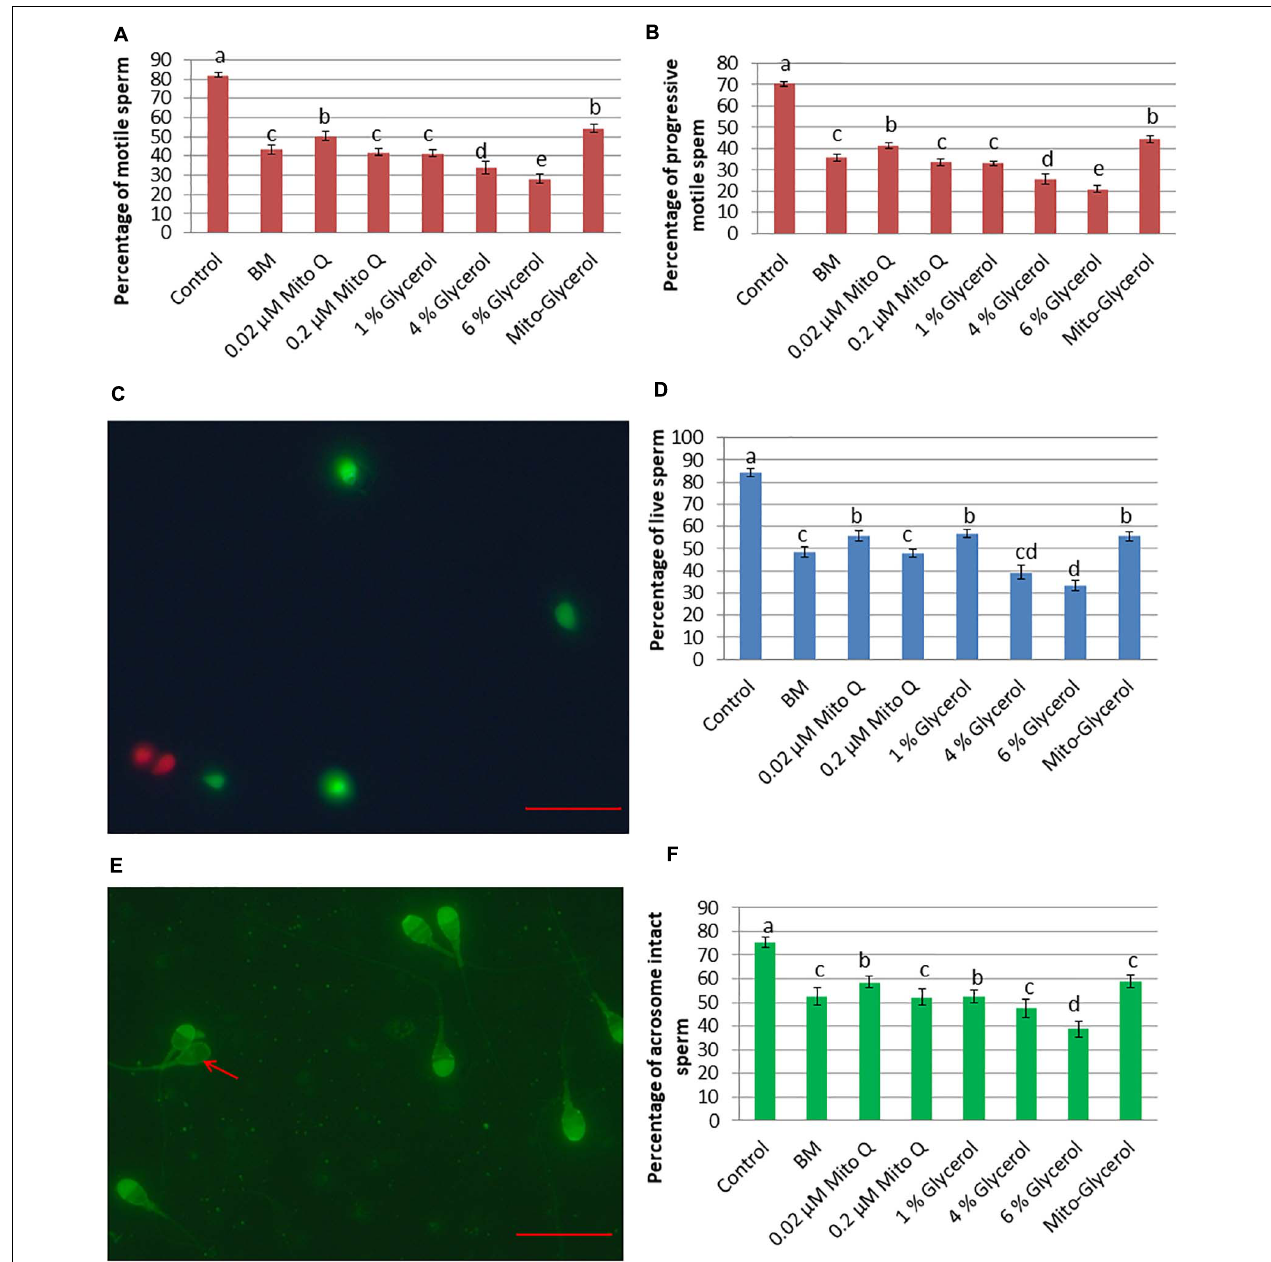
FIGURE 1 | Effect of vitrification on spermatozoa motility, vitality, and acrosomal intactness. (A) Total spermatozoa motility. (B) Progressive spermatozoa motility. (C) SYBR/PI staining. Green spermatozoa head indicates live spermatozoa, while red spermatozoa head indicates dead spermatozoa. (D) Percent live spermatozoa in fresh and vitrified spermatozoa. (E) Pisum sativum agglutinin lectin–fluorescein isothiocyanate (PSA-FITC) staining. Intact acrosome: bright fluorescence with clear-cut acrosomal cap; damaged acrosome: no fluorescence or only fluorescence of the equatorial segment or irregular acrosomal cap ( red arrow ). (F) Percent intact acrosome in fresh and vitrified spermatozoa. MitoQ , mitoquinone; BM , basal vitrification medium; Gly , glycerol; Mito-Gly , 0.02 µ M MitoQ and 1% glycerol. Values with different letters differ significantly ( p < 0.05). n = 20, where n is the number of times the experiment was replicated. Scale bar = 50 µ m.